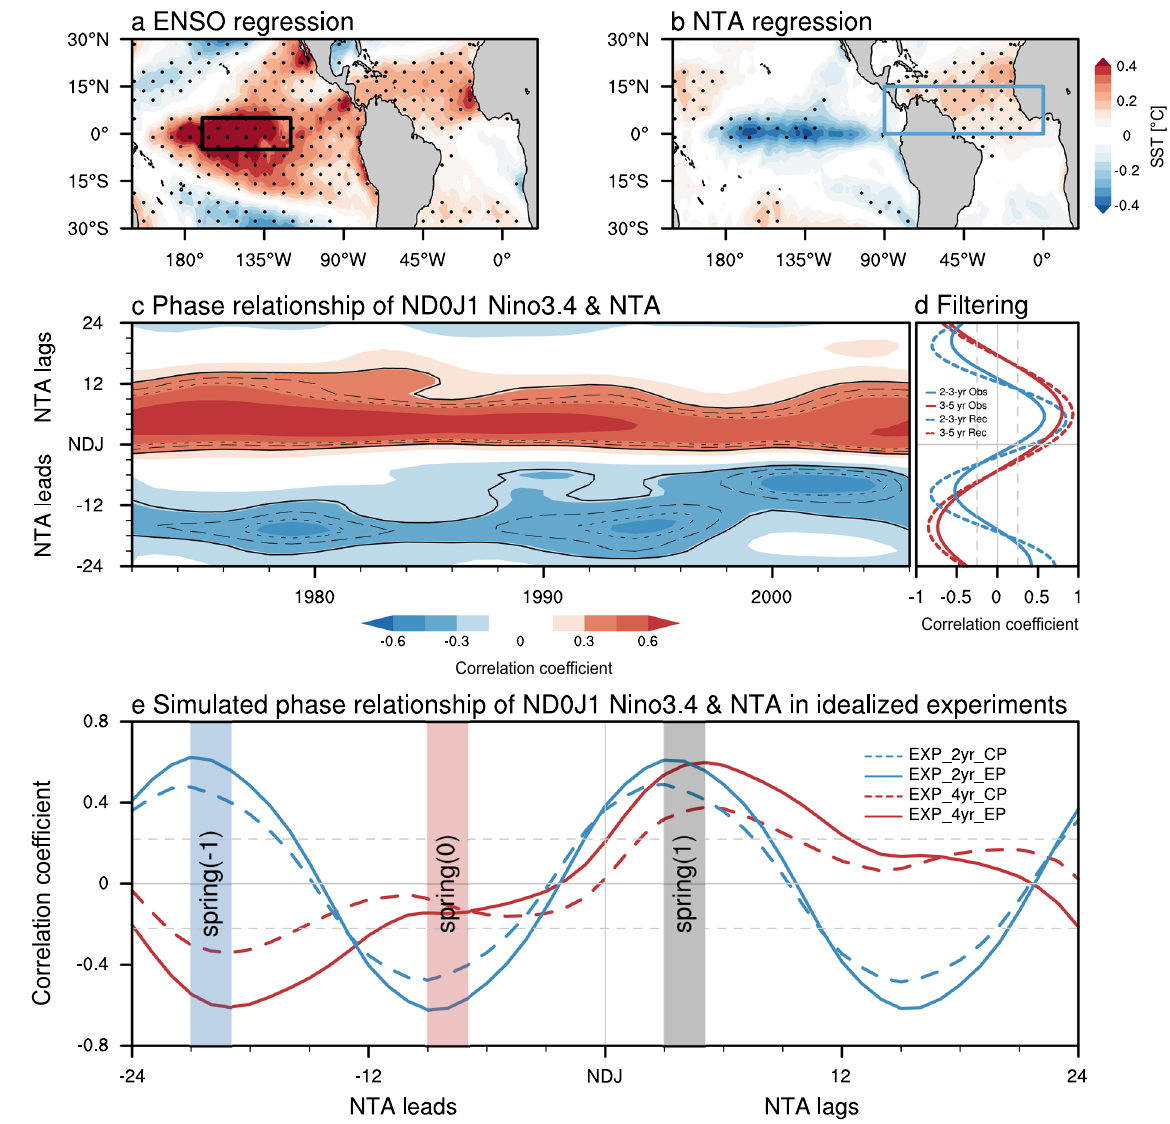
Fig. 1 Relationships between tropical Paci fi c and North Atlantic climate variability. Regression of a boreal spring (March – May) sea surface temperature (SST) anomalies (shading; °C) upon the normalized preceding winter (November – January) Niño3.4 (black box; 5°S – 5°N, 120° – 170°W) index and b boreal winter SST anomalies (shading; °C) upon the normalized preceding spring North Tropical Atlantic (NTA) (blue box; 0° – 15°N, 90° – 0°W) SST anomaly. Dots in (a-b) indicate regression coef fi cients that are statistically signi fi cant at the 95% con fi dence level. c 15-yr running lead-lagged correlation of the boreal winter Niño3.4 index with the NTA SST anomaly. Solid, dashed, and dotted lines mark the region with values exceeding the 80, 90, and 95% con fi dence levels, respectively. d Lead-lagged correlation of the boreal winter Niño3.4 index with the observed (solid) and reconstructed (dashed) NTA SST anomaly for bandpass fi ltering of 2 – 3-yr (blue) and 3 – 5-yr (red) periods by using a Fast Fourier Transform fi lter. For the y -axis of c – d , negative and positive values indicate NTA-lead and NTA-lag at monthly scale, respectively. e Lead-lagged correlation of the boreal winter Niño3.4 index with NTA SST anomaly in the idealized pacemaker experiments with different Paci fi c SST forcing (see Methods). Gray dashed lines in d – e indicate the 95% con fi dence